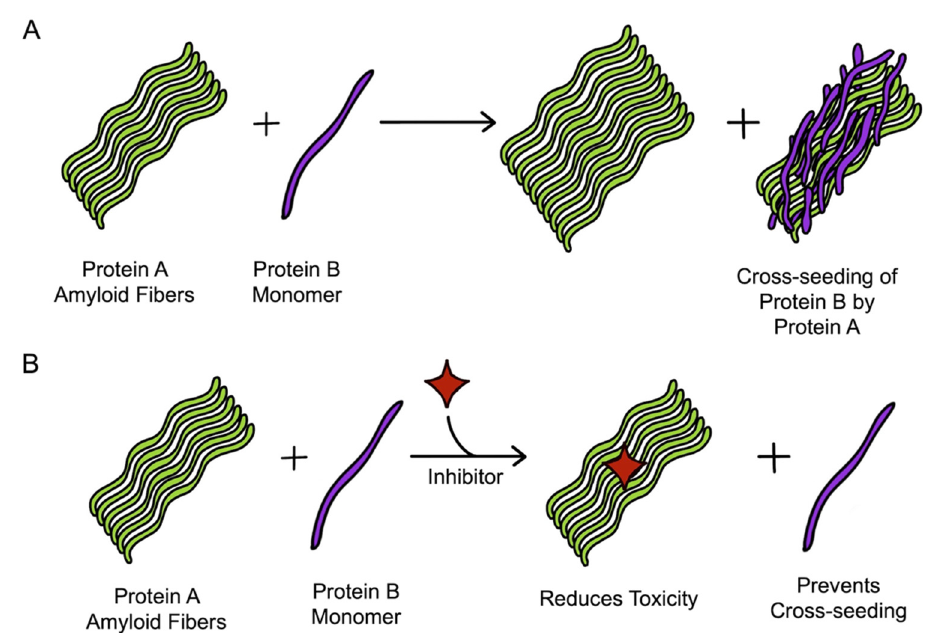
Figure 7. General mechanism of dual inhibitors of cross-seeding: ( A ) in the absence of an inhibitor, protein A acts as a seed and facilitates the cross-seeding of protein B; ( B ) in the presence of a dual inhibitor, the toxicity of the amyloid fibers of protein A is reduced, and the cross-seeding of protein B is also inhibited.